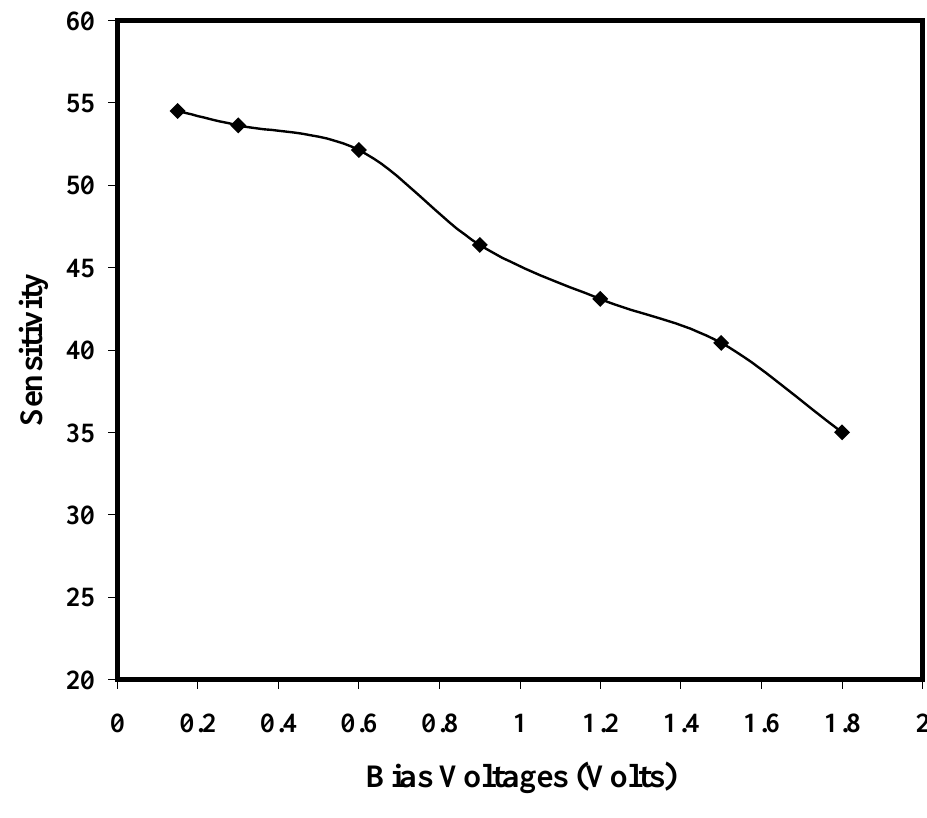
Figure 2. Sensitivity as a function of biasing voltage for SnO concentration of 1000 ppm and temperature of 350 o